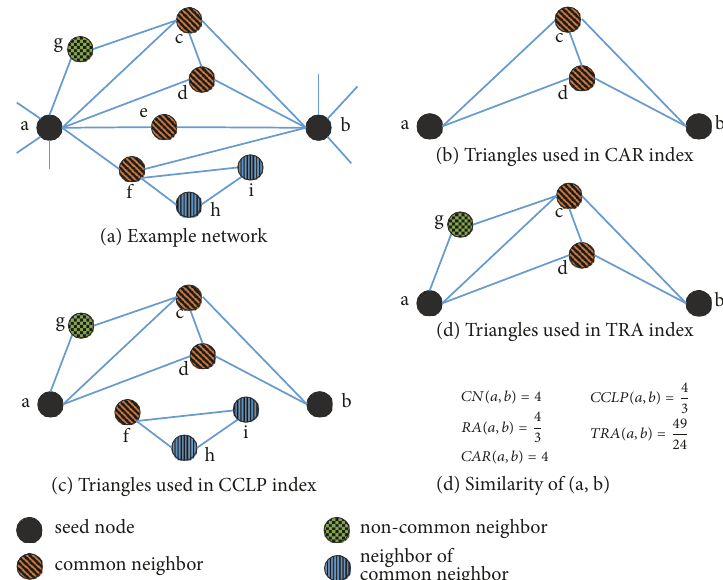
Figure 1: Triangles used in similarity